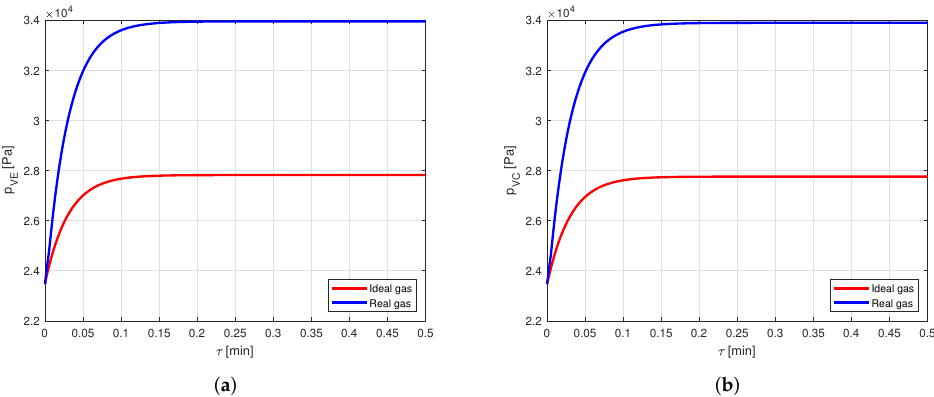
Figure 14. Comparison between the vapor pressures obtained by modeling the vapor as ideal or real gas, in an aluminum-acetone heat pipe. ( a ) Comparison of the vapor pressures at the evaporator. ( b ) Comparison of the vapor pressures at the